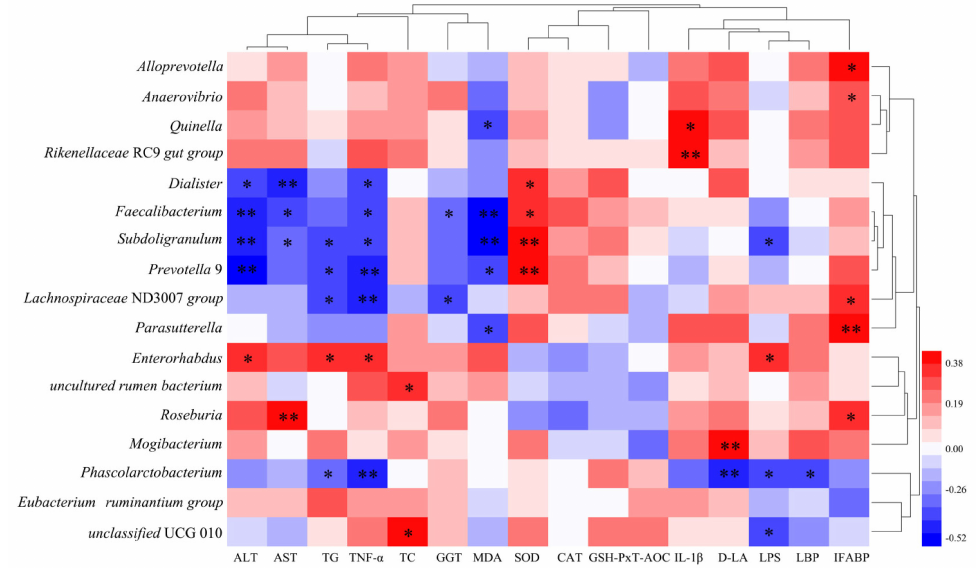
Figure 8. Correlation of differential bacterial genera with biochemical indicators. Differential bacterial genera were defined as genera with relative abundance above 0.01% in each group, including differential genera identified using Kruskal-Wallis tests for each group with BH-FDR correction for significance results. Genera identified by LEfSe analysis (LDA > 2.5) were significantly enriched in the Et and HLU groups, respectively ( p < 0.05) ( n = 6/group). (Spearman correlation analysis: correlation coefficient threshold set to 0.1, positive correlation in red, negative correlation in blue). * p < 0.05, ** p <